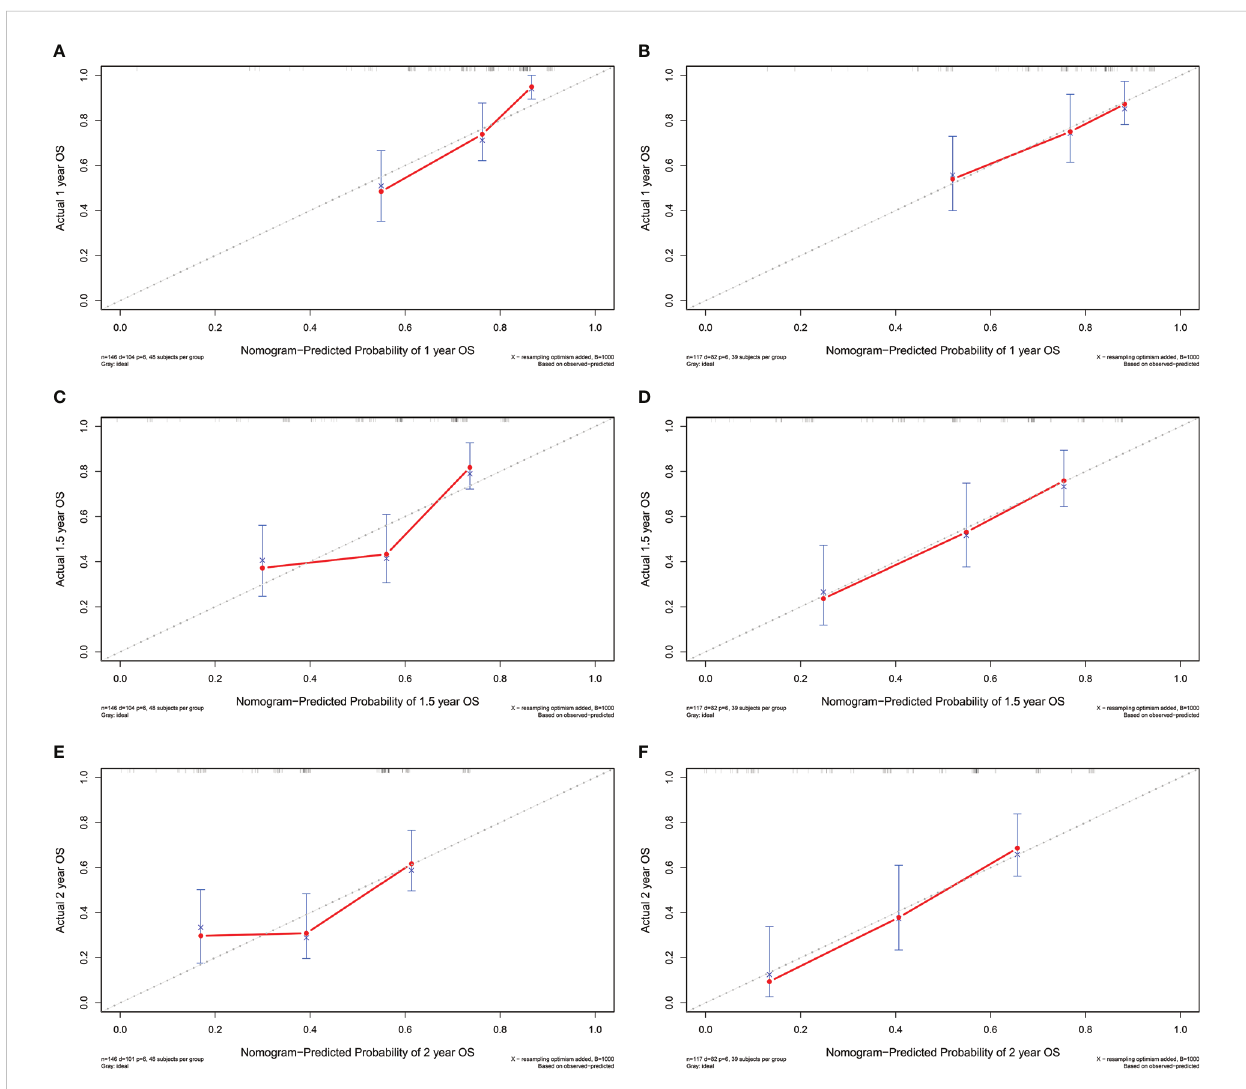
FIGURE 5 The calibration curve of the nomogram for 1-year, 1.5-year and 2-year survival of patients with resectable pancreatic cancer in the training cohort (A – C) and validation cohort (D – F) . OS, overall